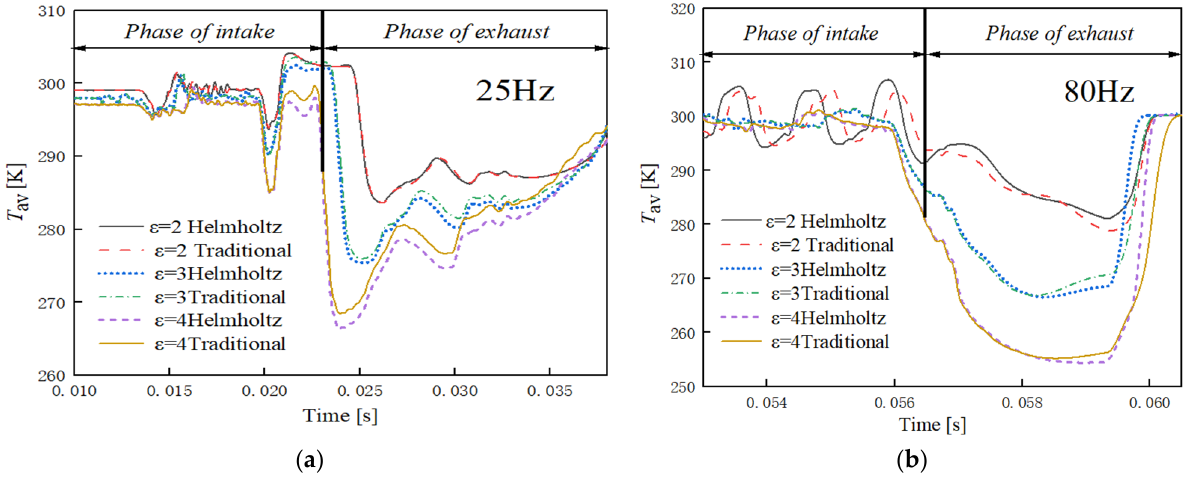
Figure 10. The variation in the total temperature T av of the two gas wave tube structures with time in one cycle: ( a ) 25 Hz; ( b ) 80 Hz.